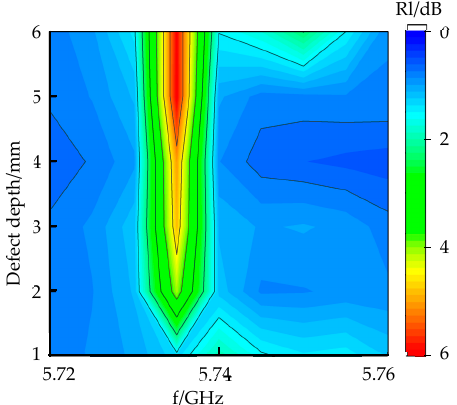
Figure 15. Crack defect signals at different depths.